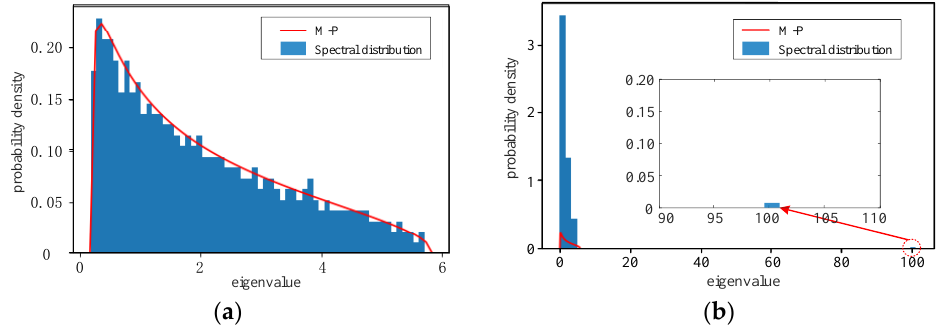
Figure 1. Analytical results of the M-P law. ( a ) Normal state, ( b ) Abnormal state.